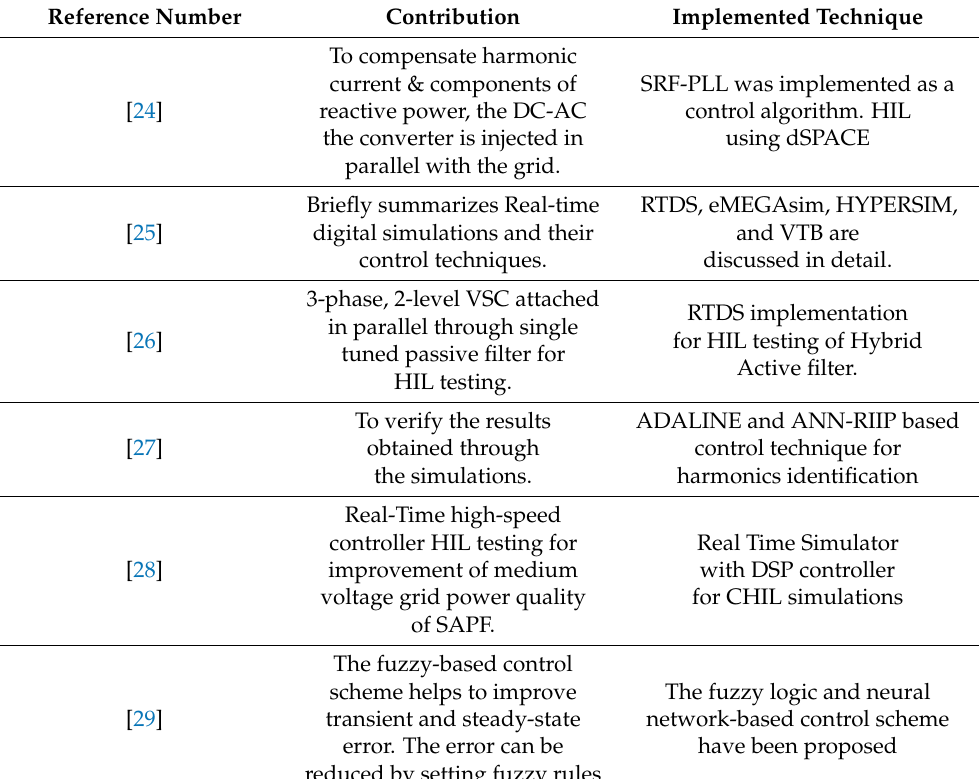
Table 1. Prominent features of Implemented Techniques in the